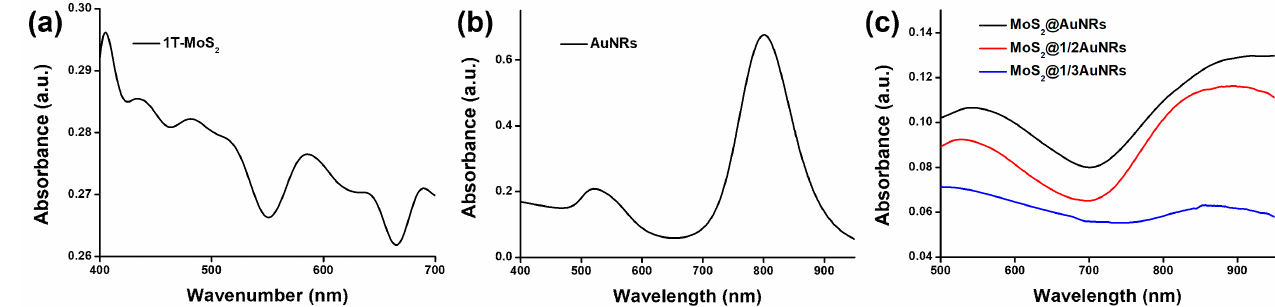
Figure 1. UV–Vis absorption spectra of ( a ) metallic molybdenum disulfide (1T-MoS 2 ) nanosheets (NSs), ( b ) gold nanorods (AuNRs), ( c ) MoS 2 @1/3AuNRs, MoS 2 @1/2AuNRs, and MoS 2 @AuNRs.